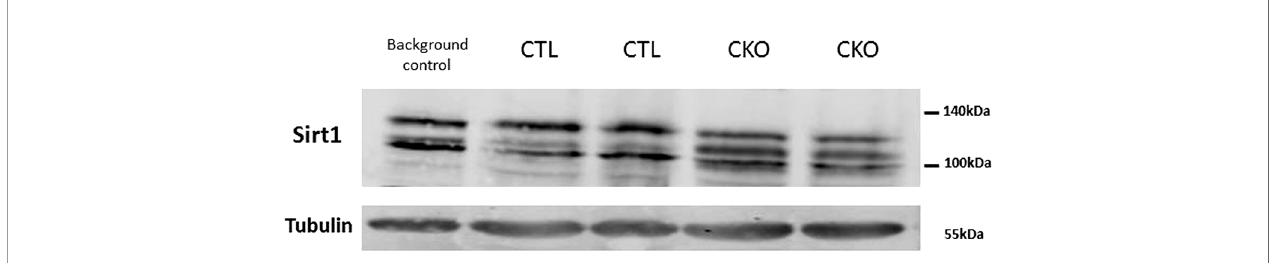
FIGURE 5 | Results of the western blot analysis of SIRT1. Signi fi cant differences in the pattern of SIRT1 in protein extracts derived from brains of C57BL mice (background control), CTL mice, CKO mice. The relative distribution of the different forms, in extracts derived from CTL mice is identical to that of other control mice (C57BL) and different from that of CKO